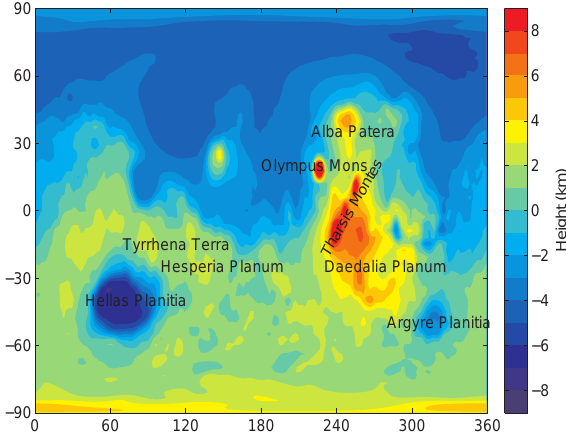
Fig. 1. Mars topography at about 2 ◦ resolution, based on Mars Global Surveyor/Mars Orbiter Laser Altimeter (MGS/MOLA) mea- surements, showing relevant